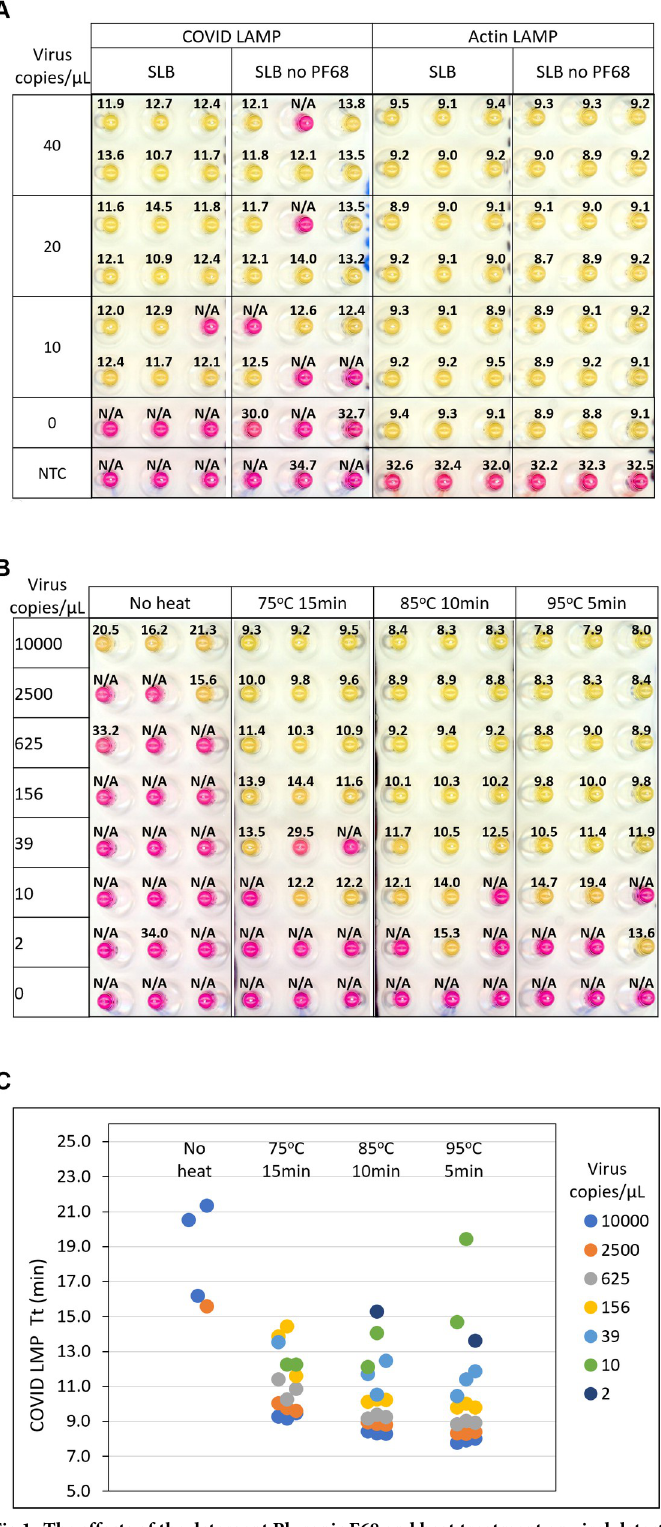
Fig 1. The effects of the detergent Pluronic F68 and heat treatment on viral detection in saliva. (A) Contrived saliva samples were processed in SLB with or without detergent followed by heat treatment (95˚C for 5 min).